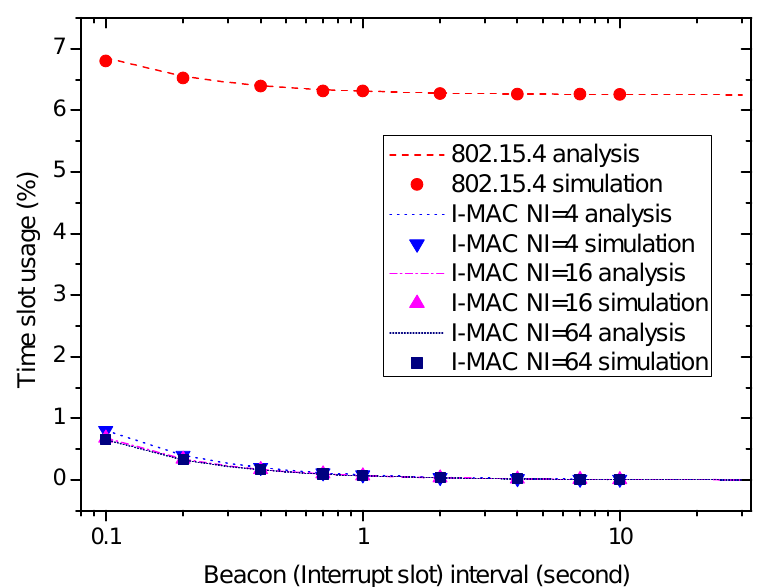
Figure 12. The effects of the beacon interval and interrupt interval on time slot usage.